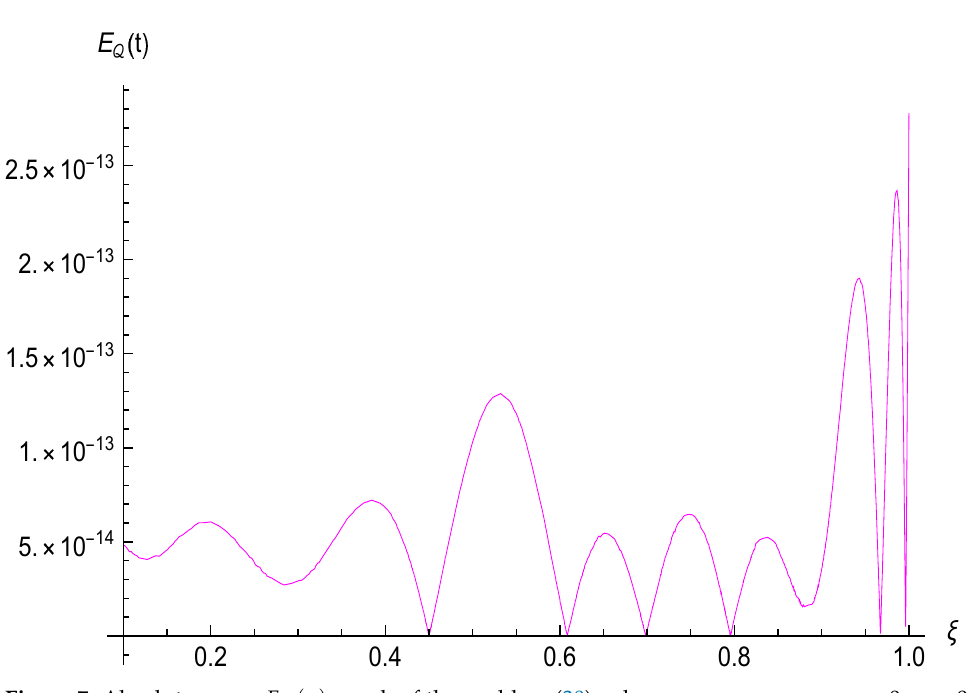
Figure 7. Absolute errors E Q ( τ ) graph of the problem (30), where σ 1 = (cid:36) 1 = σ 2 = (cid:36) 2 = 0, ν = 0.5 and N = M = 16.